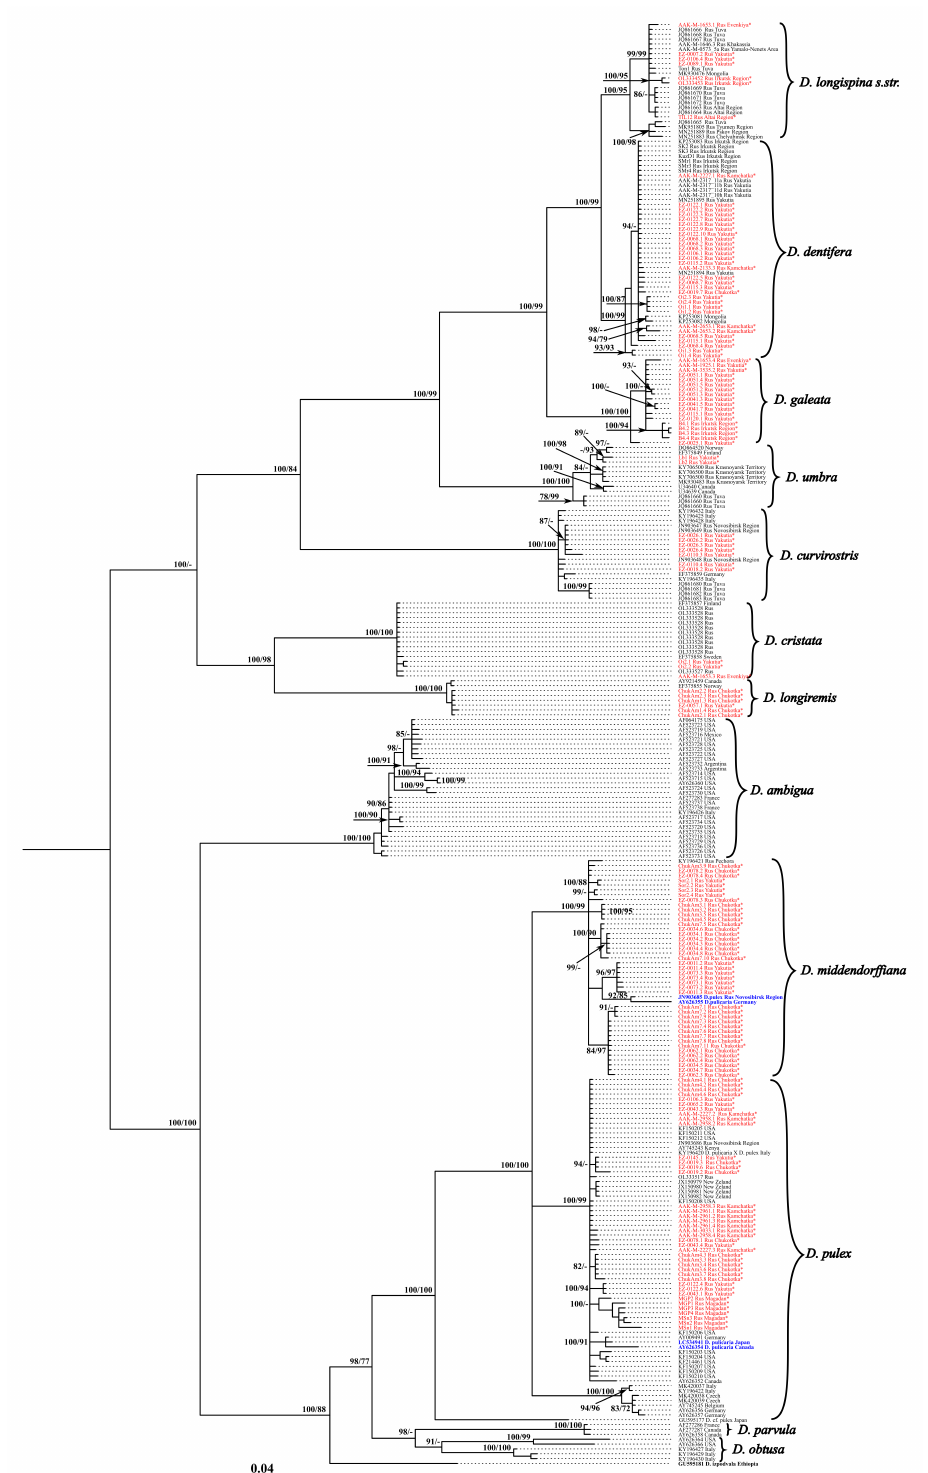
Figure 2. Bayesian phylogenetic tree for the Daphnia species based on the 12S sequences (original and obtained from the GenBank database, Table S2). Bayesian posterior probabilities BI and bootstrap values from ML analysis above 72% expressed as a percentage are indicated for each significant node; red *—new nucleotide sequences; blue—ambiguous specific status of the GenBank sequences. Scale is given in expected substitutions per